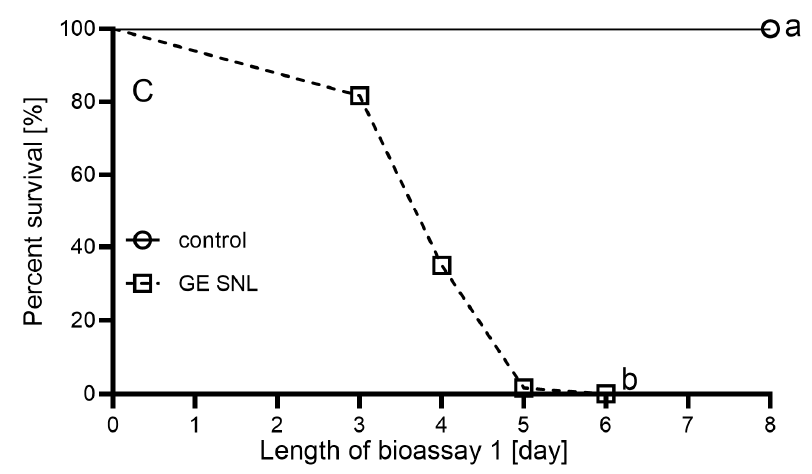
Figure 2. Survival of L. decemlineata larvae on the semi-artificial diet with different concentrations of recombinant ( A ) and natural ( B ) Cry3Aa, and on the leaves of GE potato SNL plants expressing Cry3Aa ( C ) in bioassay 1. The same letters denote non-significant differences, while different letters denote statistically significant differences in trend of survival between treatments. The values of statistical tests are available in Table S1A.